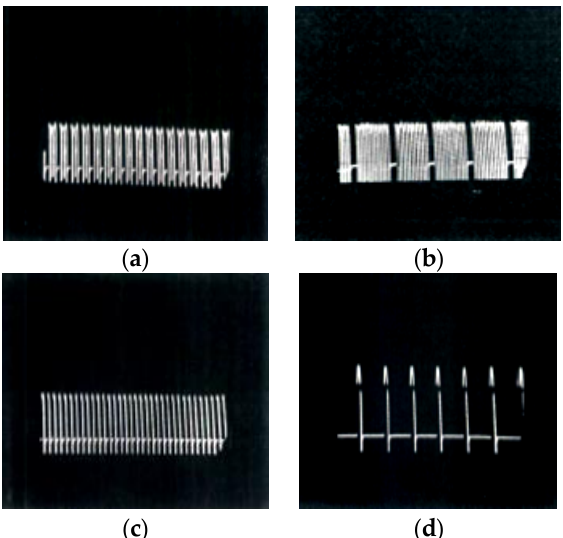
Figure 14. Typical wave form of thyristor-type SPS pulse generators (ON-OFF ratio in 50 Hz). ( a ) 3:1 (9.9 ms:3.3 ms); ( b ) 12:2 (39.6 ms:6.6 ms); ( c ) 1:1 (3.3 ms:3.3 ms); ( d ) 1:9 (3.3 ms:29.7 ms)).